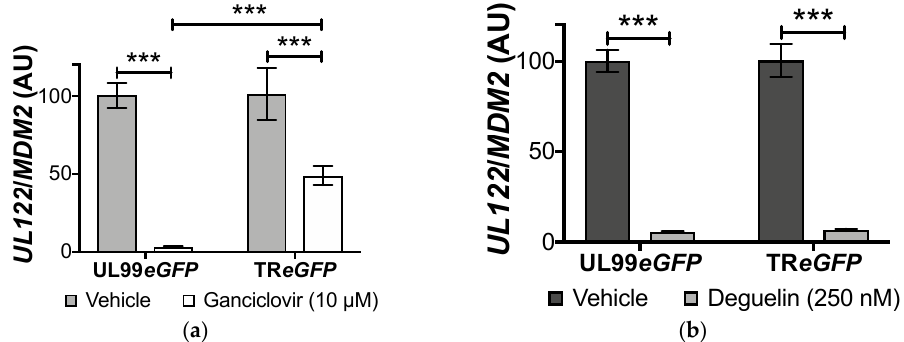
Figure 4. Ganciclovir-resistant HCMV is sensitive to deguelin treatment. NuFF-1 cells were treated with ( a ) ganciclovir (10 μ M) or ( b ) deguelin (250 nM) for 1 h, after which cultures were infected with